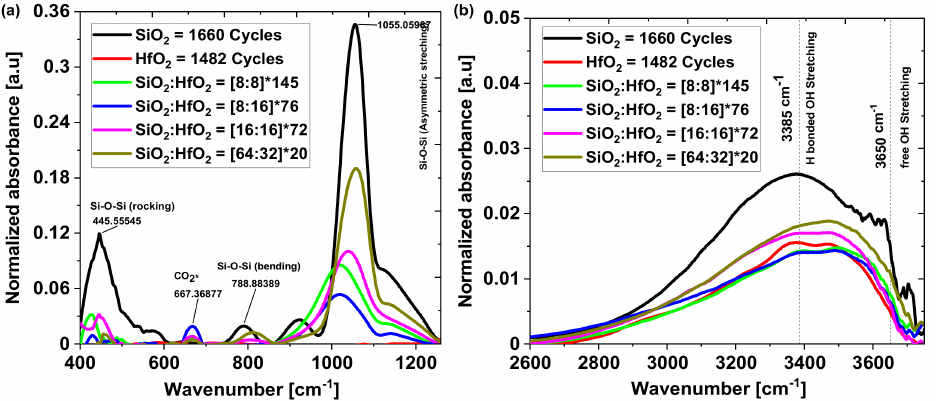
Figure 10. FTIR absorption spectra of the heterostructures from ( a ) 400 to 1200 cm − 1 and ( b ) 2600 to 3750 cm − 1